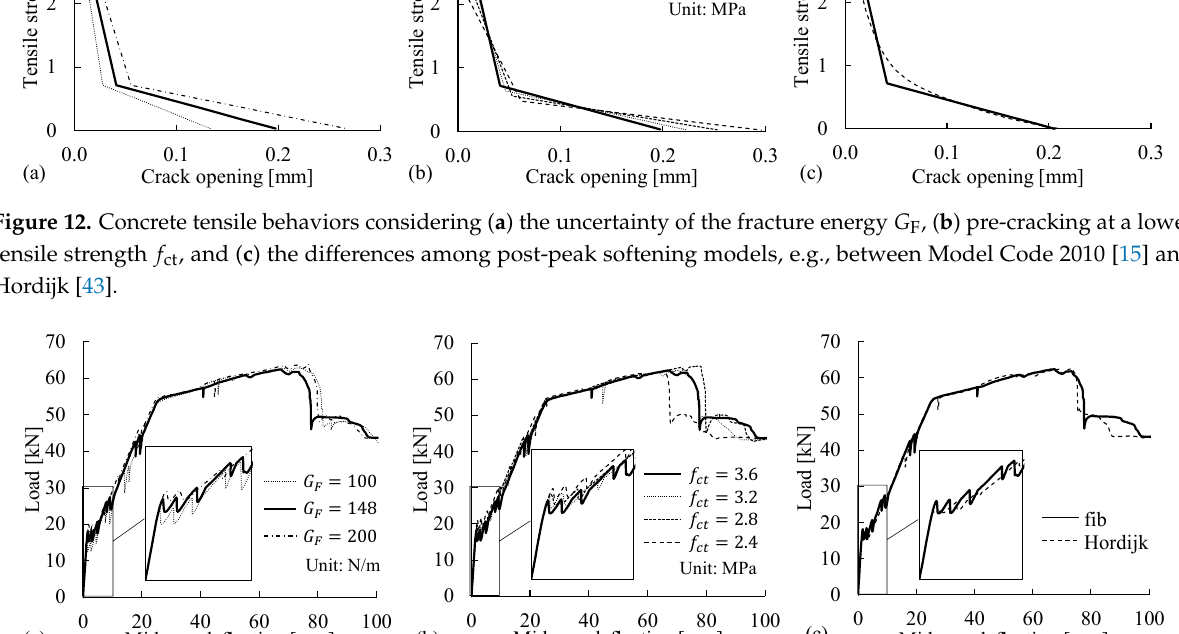
, and ( c ) the post-peak softening behavior. ct